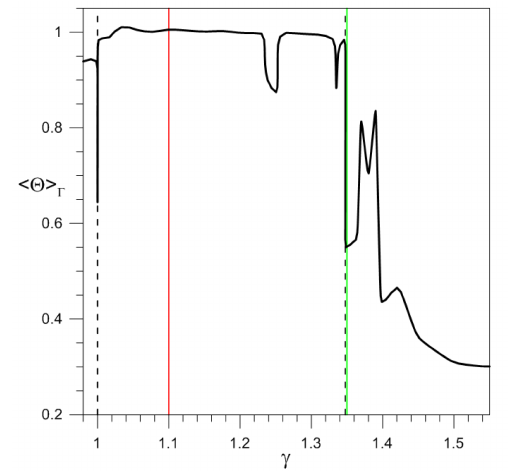
Figure 14. Same as Fig. 13, but for the autonomous model with ε = 0 and the amplitude γ of the time-independent forcing on the abscissa. The vertical red and green lines denote the periodic and the chaotic cases, respectively, that were analyzed in Sect. 3.1; see again Fig. 1. Please see the text for the interpretation of the dashed lines corresponding to γ c = 1 and γ 0 = 1 .